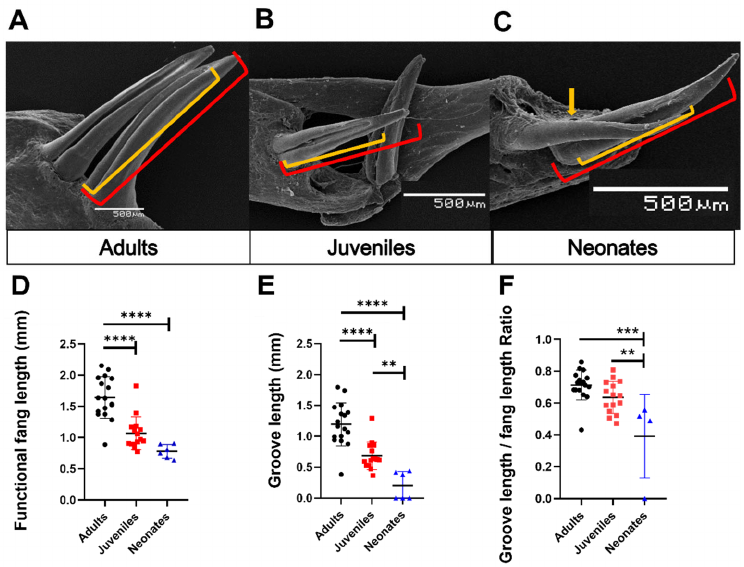
Figure 9. Ontogenetic variations of fang characteristics in Galvarinus ch. chilensis . ( A – C ) SEM images detailing the anatomical characteristics of fangs in adult (MZUC 45,037), juvenile (MZUC 45,334), and neonate (MZUC 45,031) specimens. Changes in the ( D ) functional fang length, ( E ) groove length, and ( F ) groove length/functional fang length ratio. Data shown are mean ± SD from all functional fangs (left and right) of adults (N = 10), juveniles (N = 9), and neonates (N = 4). ** p < 0.01, *** p < 0.001, **** p < 0.0001. Brackets indicate orange = groove and red = total fang length. The orange arrow indicates the absence of a groove.